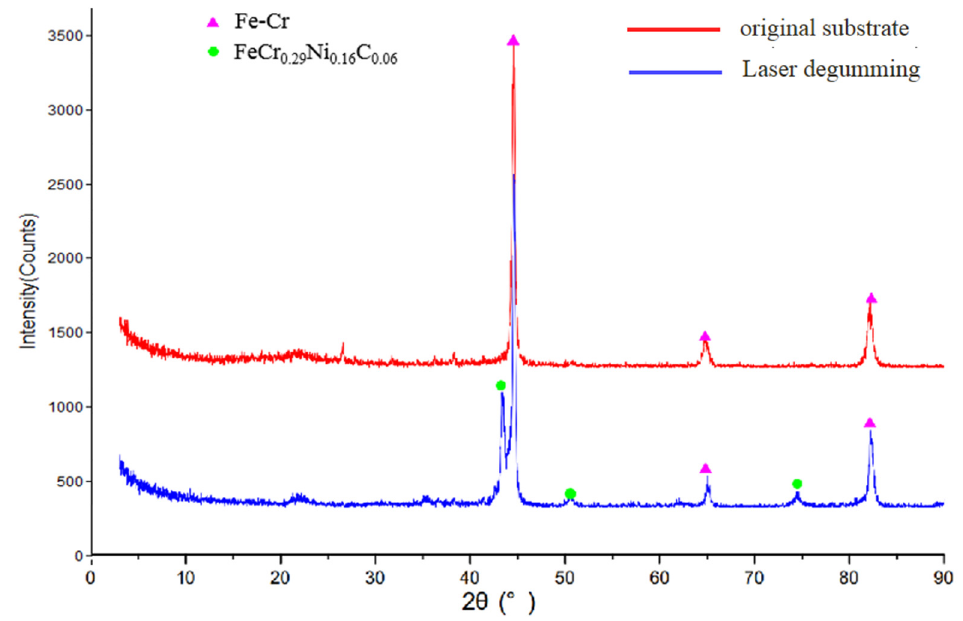
Figure 7. Composition test of samples before (red line) and after (blue line) laser